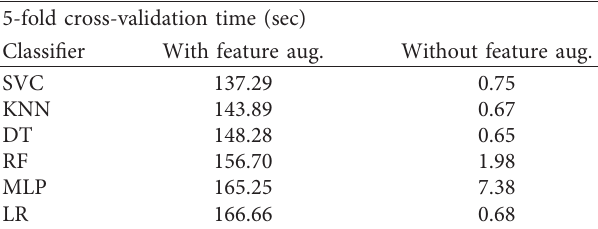
Table 7: Time measurements of 5-fold